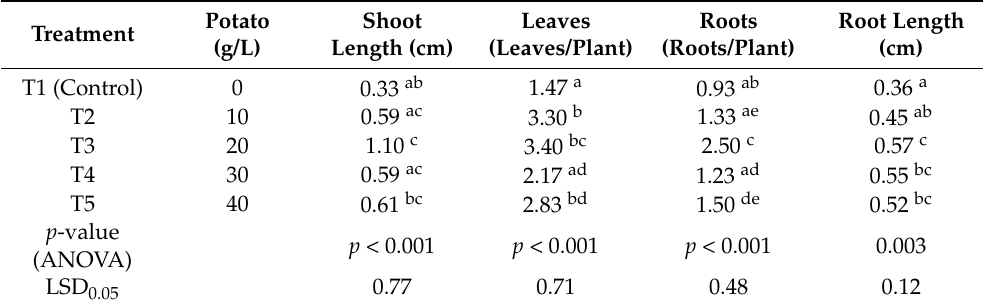
Table 5. Effect of mashed potato on the growth and development of D. anosmum Lindl. (6 weeks after culturing).